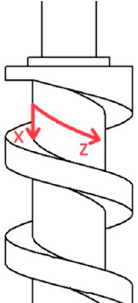
Figure 1. Definitions of x and z directions for the general equations for melt removal by drag.